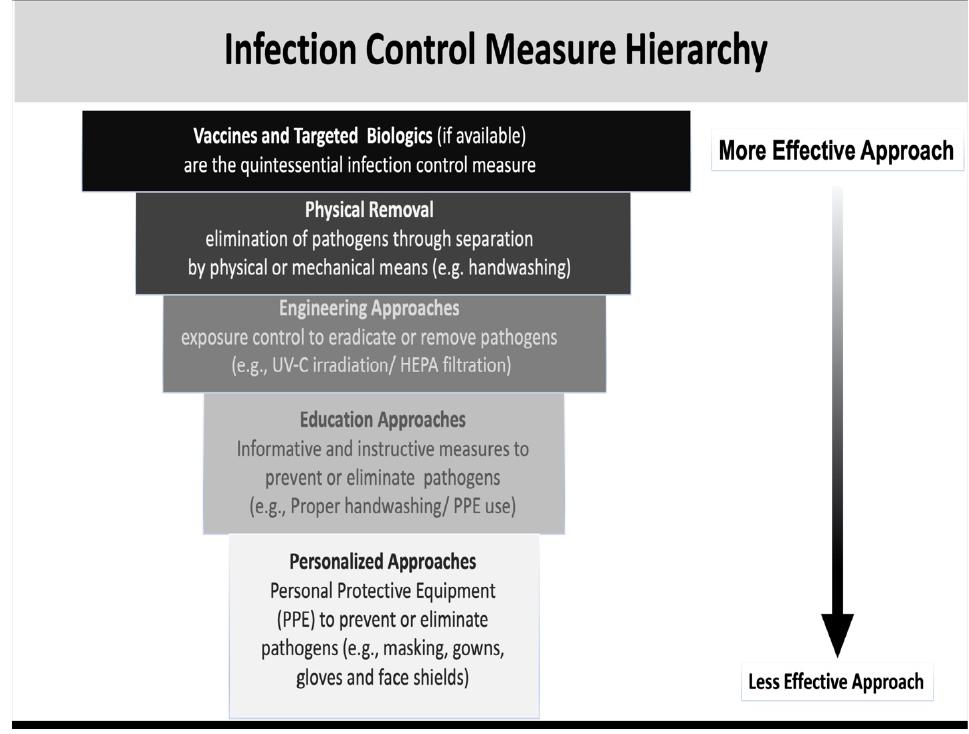
Figure 1. Infection control hierarchy. Adapted from Centers for Disease Control topics of control 2015. Showing approaches established to be effective in eliminating viral pathogens.